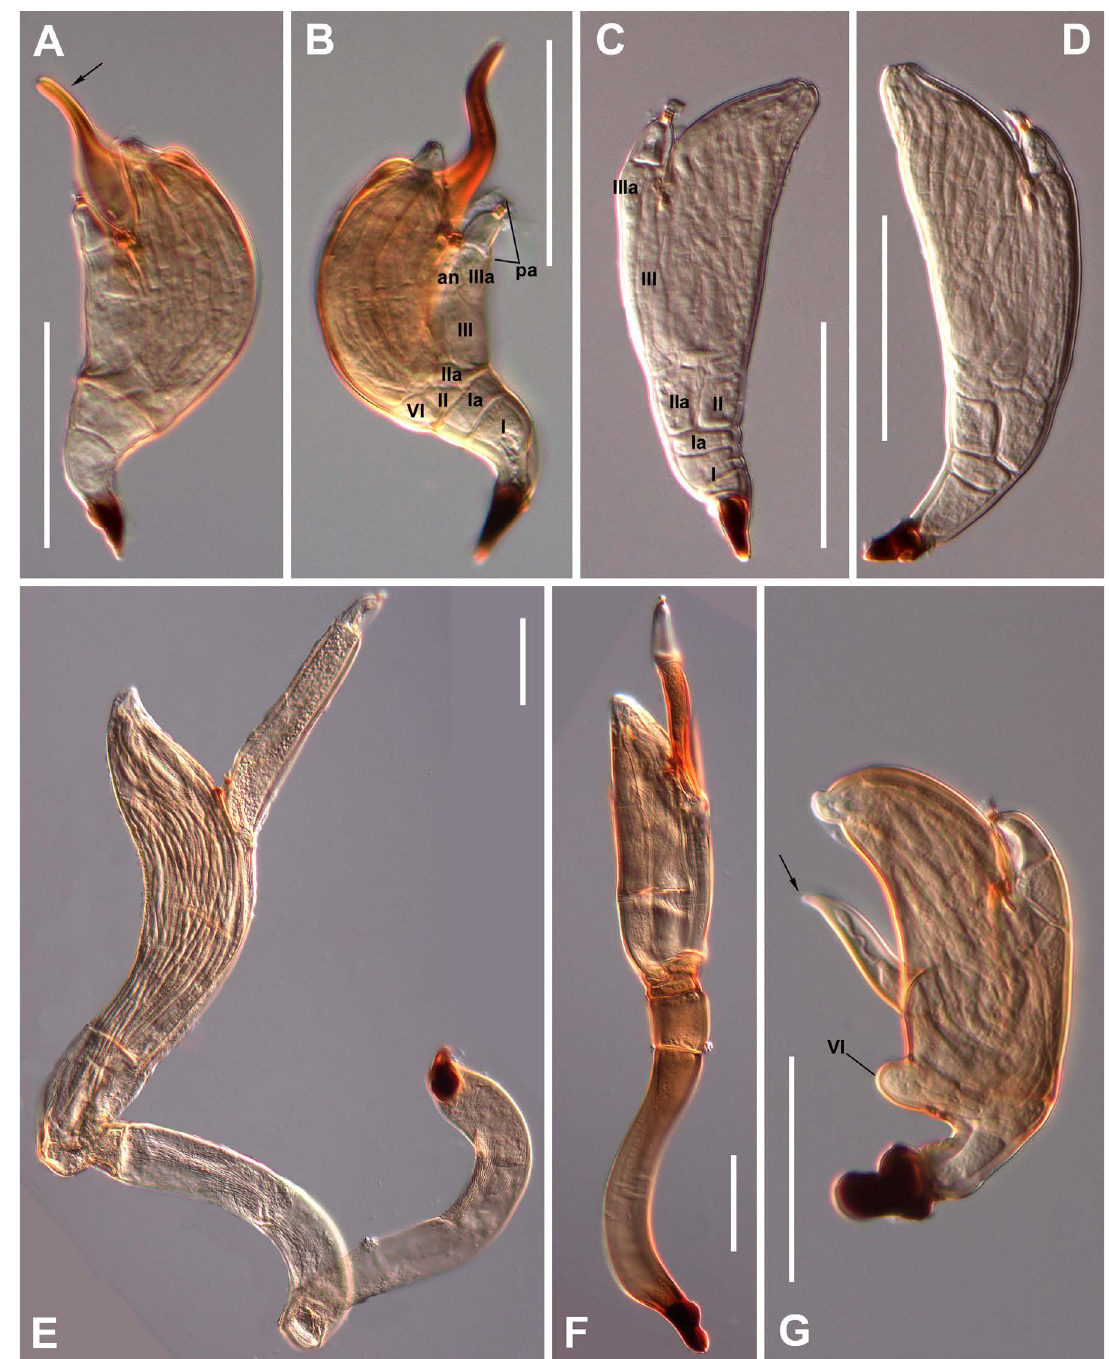
Fig. 20. Chitonomyces spp. A – B . C. aculeifer Speg. Mature thalli with labelling of cells and other parts of the thallus, i.e., cells I, Ia, II, IIa, III, IIIa, VI, antheridium (an), primary appendage (pa) and perithecial outgrowth (arrow). A . From Graptodytes . B . From Haliplus . – C – D . C. bidessarius (Thaxt.) Thaxt. Mature thalli with labelling of cells of the thallus, i.e., cells I, Ia, II, IIa, III, and IIIa. – E – F . C. elongatus Speg. E . Thallus from a female host. F . Thallus from a male host. – G . C. ensifer Speg. Mature thallus showing prominent cell VI and perithecial outgrowth (arrow). Scale bars: 50 µm. Photographs from slides ZMUC C-F-123553 (A), ZMUC C-F-124083 (B), ZMUC C-F-122816 (C–D), ZMUC C-F-124060 (E), ZMUC C-F-124061 (F), ZMUC C-F-123670